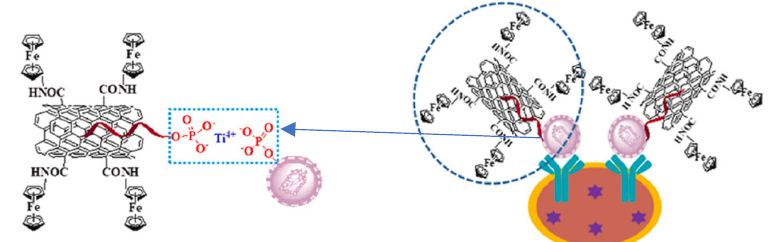
Figure 22. A549 exosomes detection principle by means of sandwich immunoassay labeled with SWCNTs conjugated with DNA and ferrocene. Adapted with permission from Si et al. [131] (copyright © (2023), Elsevier).